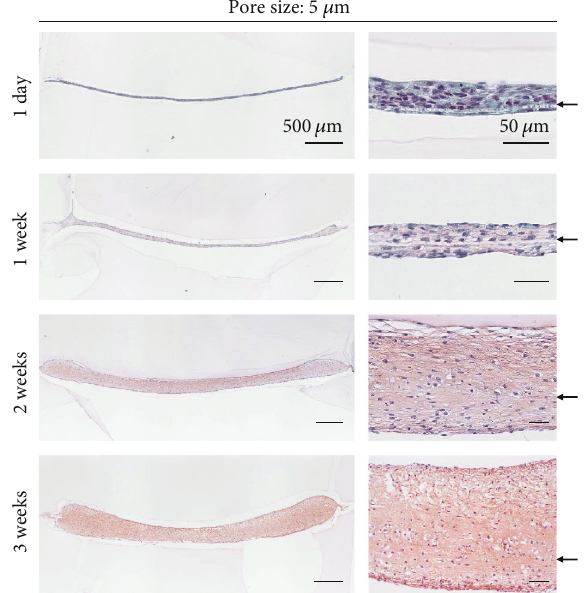
Figure 6: Temporal alteration in histological images of in vitro cartilage formation of synovial MSCs plated on PLA fi lms with 5 μ m pores. MSCs ( 5 : 0 × 10 5 in 500 μ L medium) were plated, cultured in chondrogenic induction medium for three weeks, and stained with safranin O. The arrow indicates the PLA fi